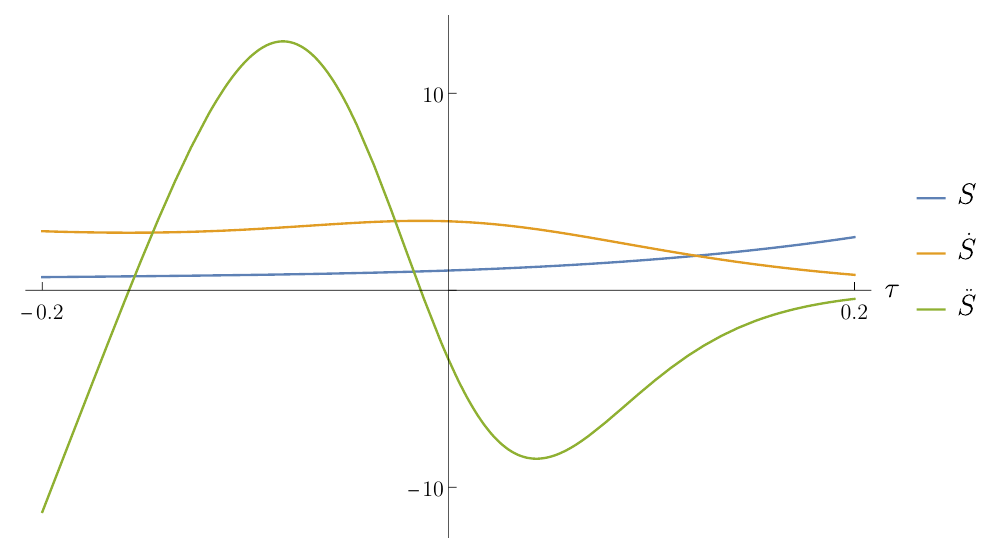
˙ ¨ S, S as functions of τ , with parameter = 0 . 30408 max